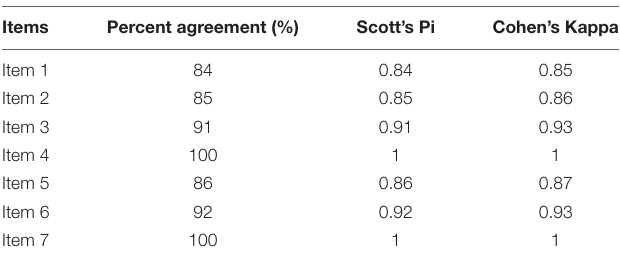
TABLE 2 | Interrater reliability of interview.